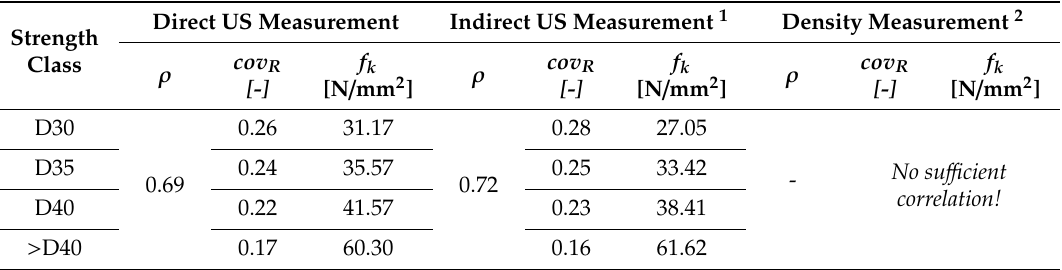
Table 2. Results for oak samples and different grading techniques obtained from the stochastic grading model.